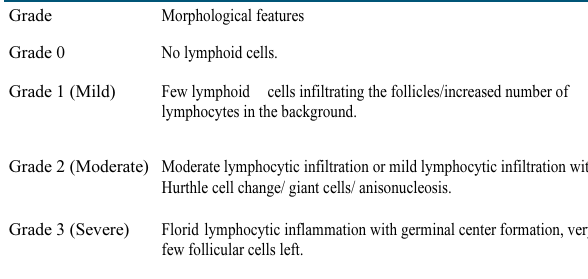
Ft3, FT4, TSH and anti-TPO antibodies were analyzed by Siemens XP fully automated hormone assay using chemiluminescence assay. The normal values for FT3, FT4, TSH and anti-TPO was taken as 1.08-3.14 nmol/L, 0.8-2.3ng/dl, 0.4-4.0 mIU/L and 7-50 IU/mL